Question: What style of plot is this figure drawn as?
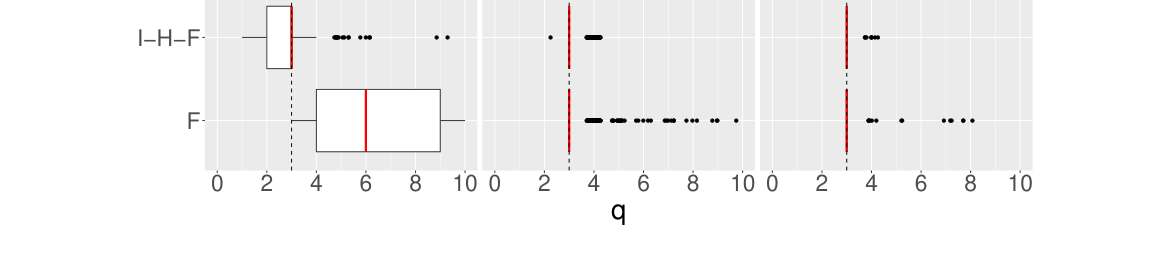
Answer: box